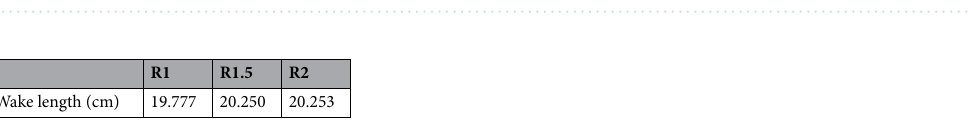
Figure 13. Vector plots of flow field around strands for strand ratio R of 1 & 2 and Reynolds numbers of 150 and 200.